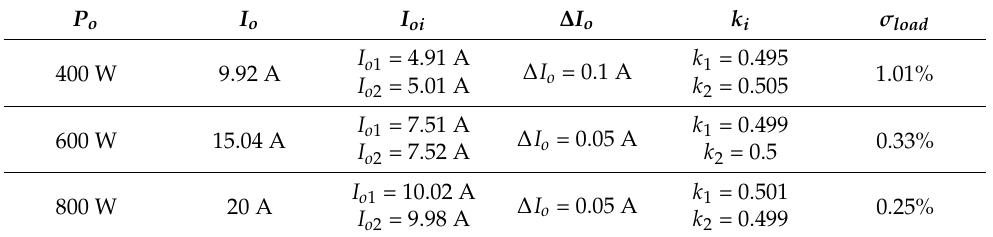
Table 9. Data comparison of different output power after using DHC when c = 1.2.